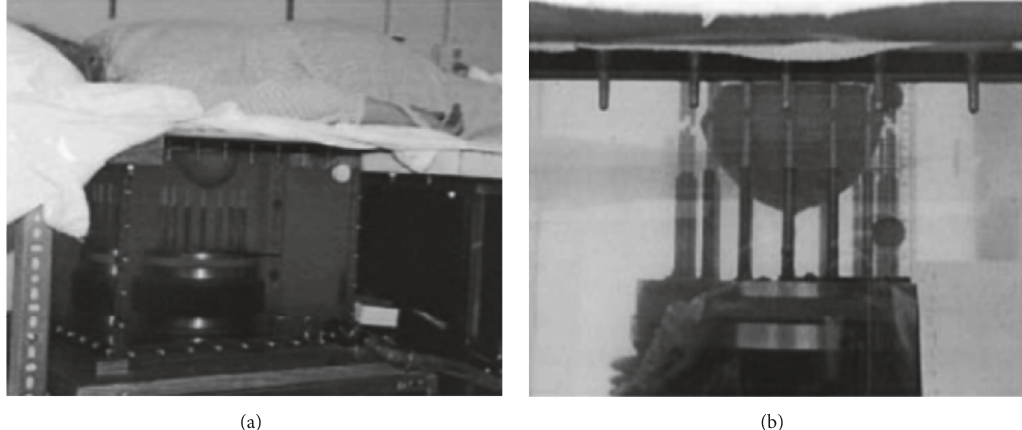
Figure 8: Photographs of a microwave exam with patient in Dartmouth College. (a) Close-up view, and (b) the breast in position within the center of the antenna array [18]. Image copyright IEEE, used with permission.